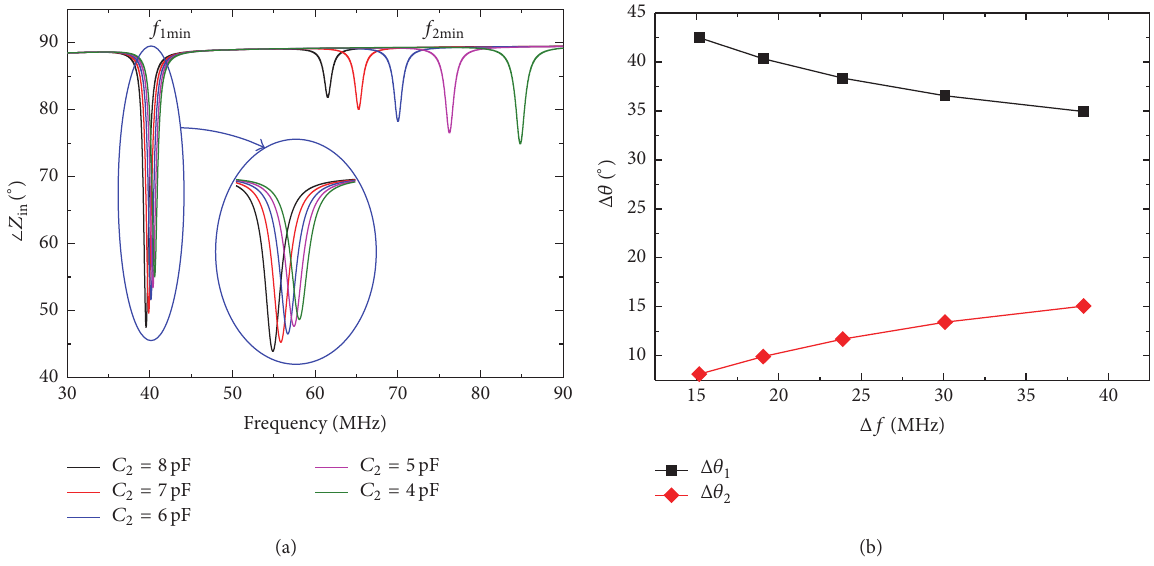
Figure 10: (a) Phase versus frequency curve of the readout coil when Δ𝑓 increased and (b) the influence of Δ𝑓 on the value of Δ𝜃 1 and Δ𝜃 2 .